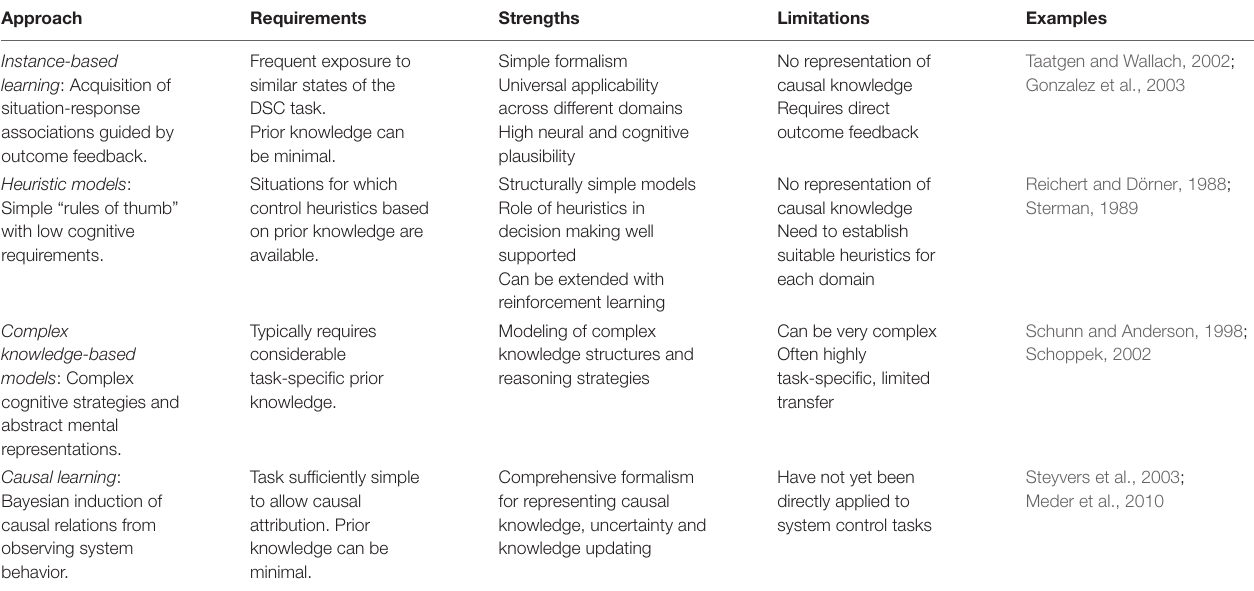
TABLE 1 | Basic approaches to cognitive modeling in dynamic systems control (DSC).